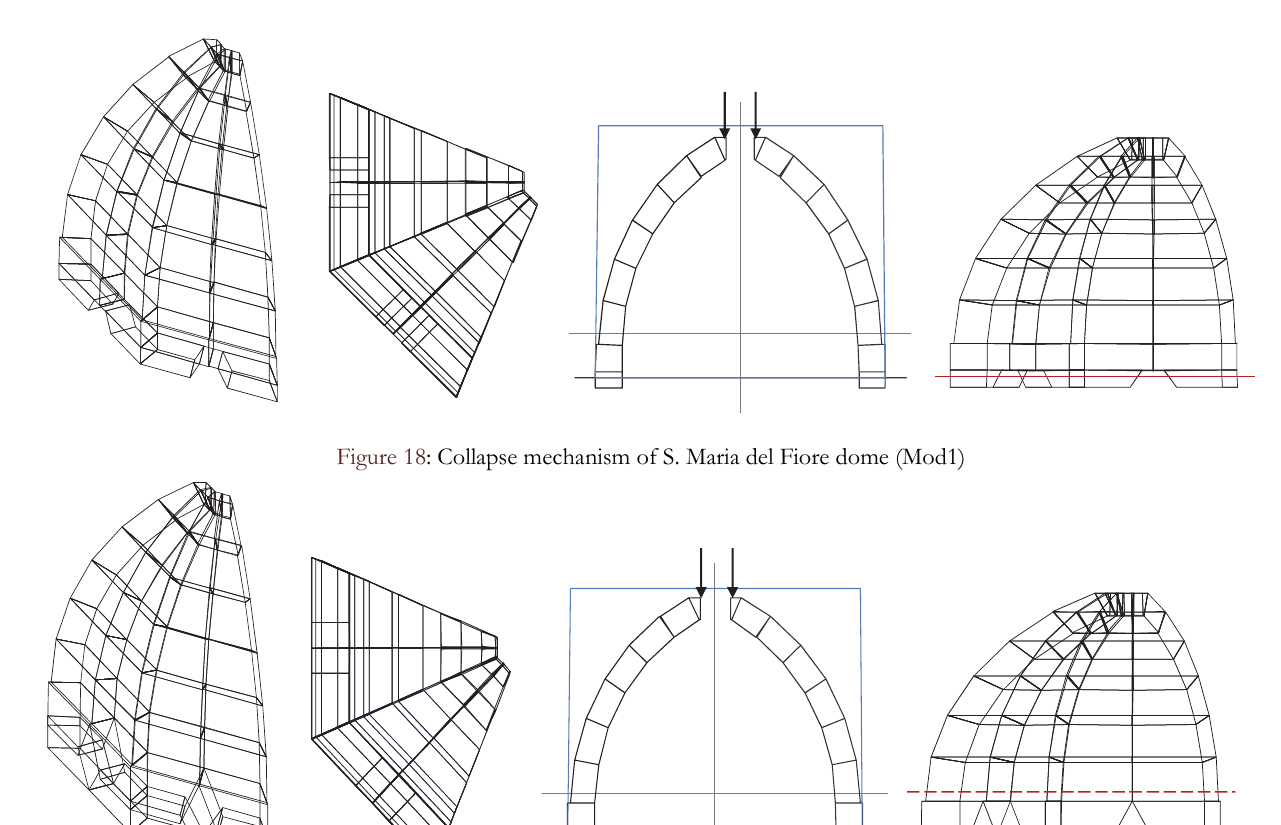
Table 5: Comparison between the values obtained with Mod1 and Mod2